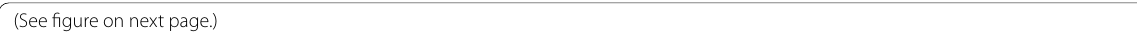
Fig. 6 Qualitative and quantitative analysis of proteins involved in mitochondrial fission and outer membrane fusion. Protein lysates of porcine aortic endothelial cells incubated for 3 h, 6 h, 24 h or 48 h at 4 °C and rewarmed for 1 h at 37 °C were analysed by western blot ( A ) for protein levels of Drp1 and phosphorylation of Drp1 (activating site p-Drp1-S616 and inactivating site p-Drp1-S637) and Fis1. Additionally Mff, p-Mff Ser146, MiD49, MiD51, Mfn1 and Mfn2 were targeted. Coomassie staining was used as loading control (coom.). Representative figures of n The band intensity was quantified using the BioVision software and normalized to the control ( B – D ). Rewarming conditions are shown hatched. Means SD of n 4 experiments. * Significantly different to control (p ± = incubation (p